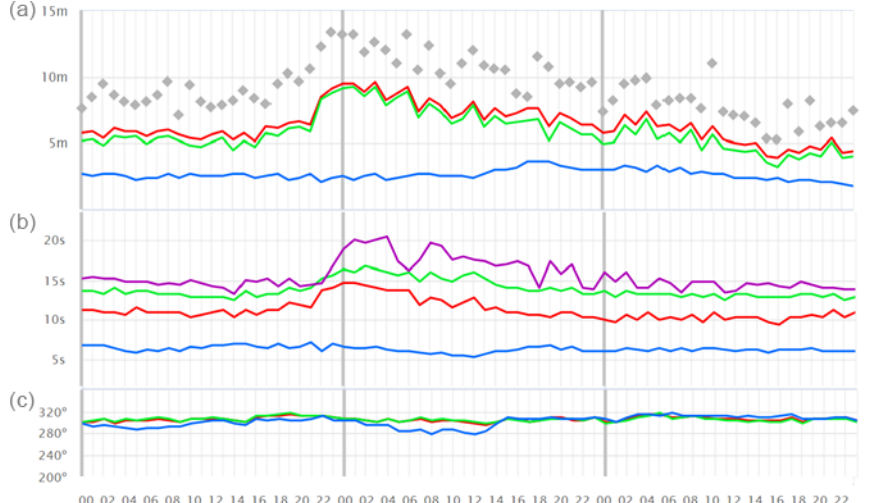
Figure 3. Wave height (a) , period (b) and direction (c) in Donostia buoy. Significant wave (red), maximum wave (dots), swell wave (green) and wind wave (blue), peak wave period (magenta).